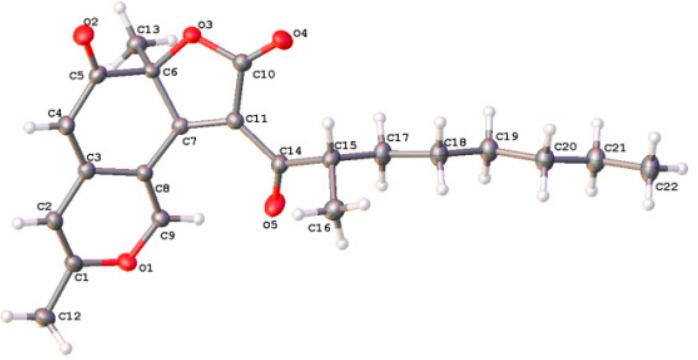
Figure 4. X-ray structure of compound 5 , drawn by Olex2 . Table 3. 1 H (500 MHz) and 13 C-NMR (125 MHz) data for compounds 5 (CD 3 OD) .